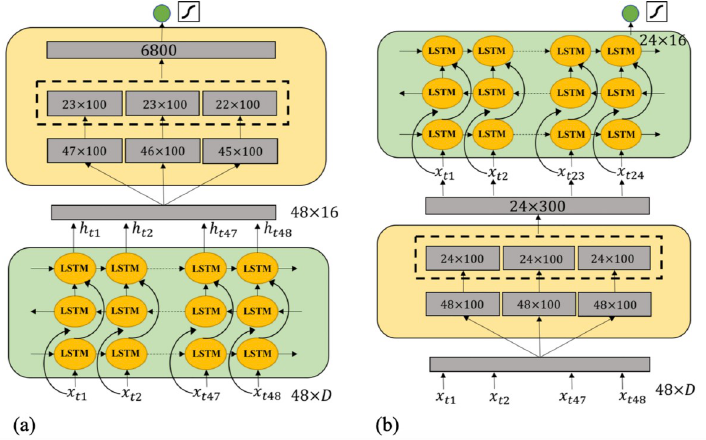
Fig 5. Combination of LSTM and CNN models. (a) CNN+LSTM model, the CNN follows a multi-filter convolution computation with zero padding to maintain the timestamp consistency for different groups of feature maps. The following LSTM only outputs the hidden units of the last time stamp. (b) LSTM+CNN model, CNN computes the feature maps without zero padding after receiving the output hidden unit sequence from LSTM.